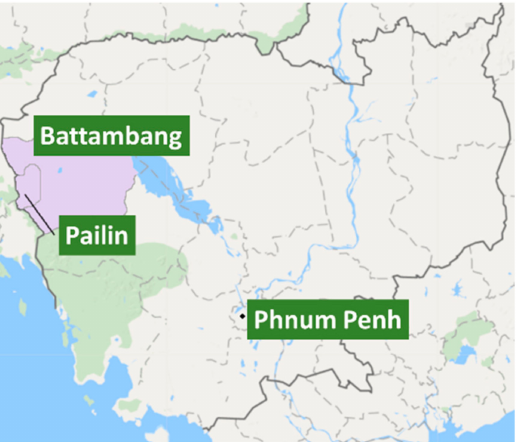
Figure 1. Survey areas in Cambodia (created by the authors using Google